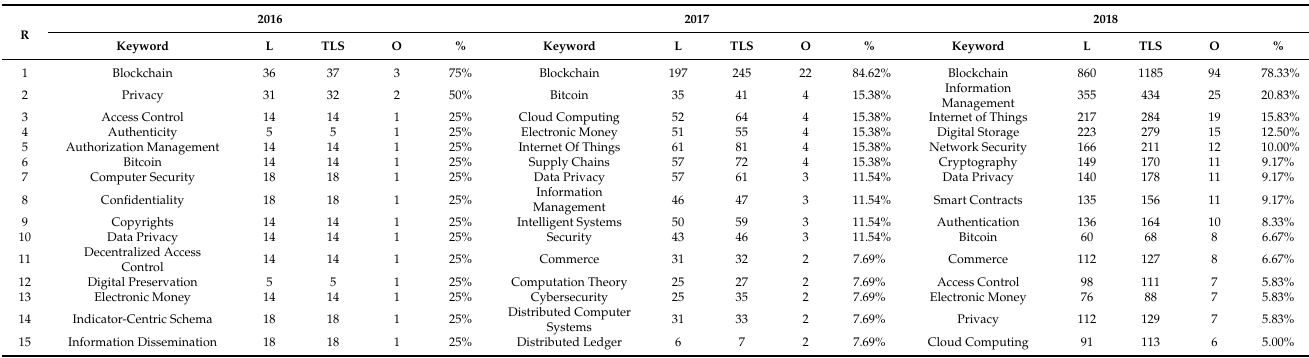
Table 2 shows the 15 top keywords in the years 2016, 2017 and 2018. For each term the links, the total link strength, and the occurrences are provided. These are ordered by the number of occurrences. Table 2. Top 15 keywords per period (2016, 2017 and